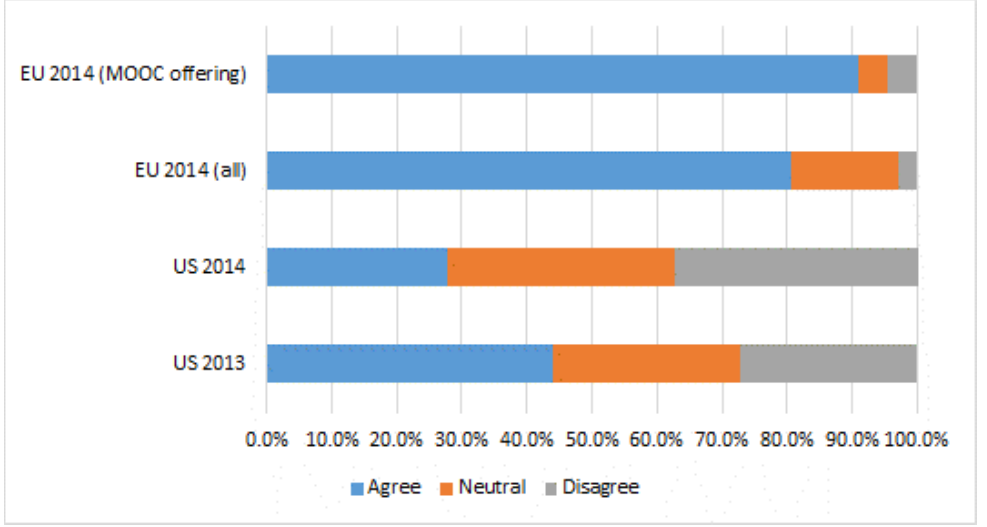
Figure 3. MOOCs are important for institutions to learn about online pedagogy.